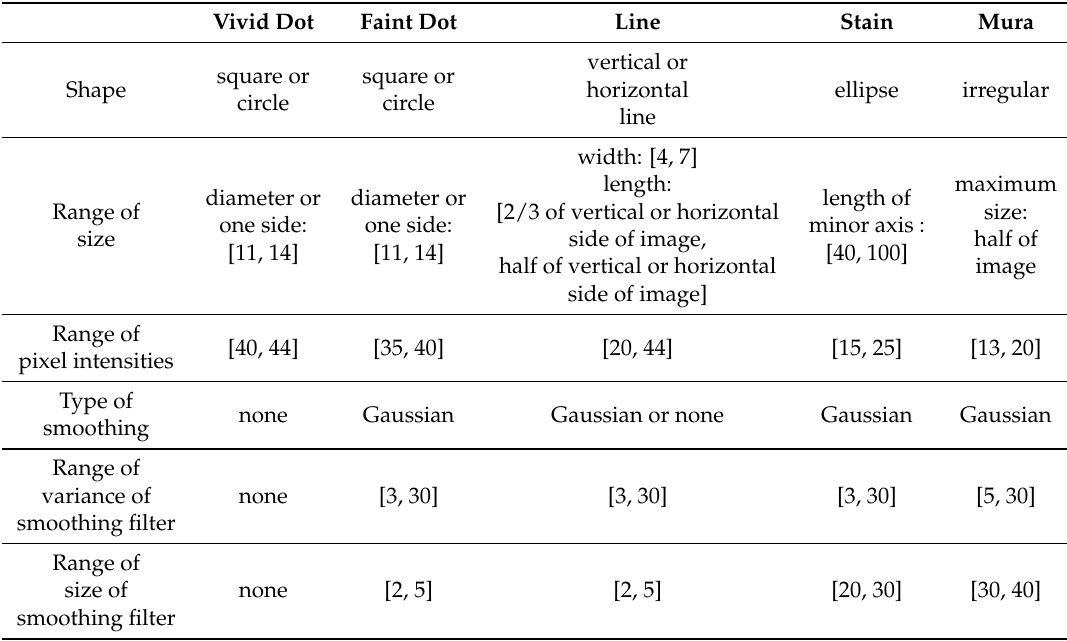
Table 2. Ranges and settings for